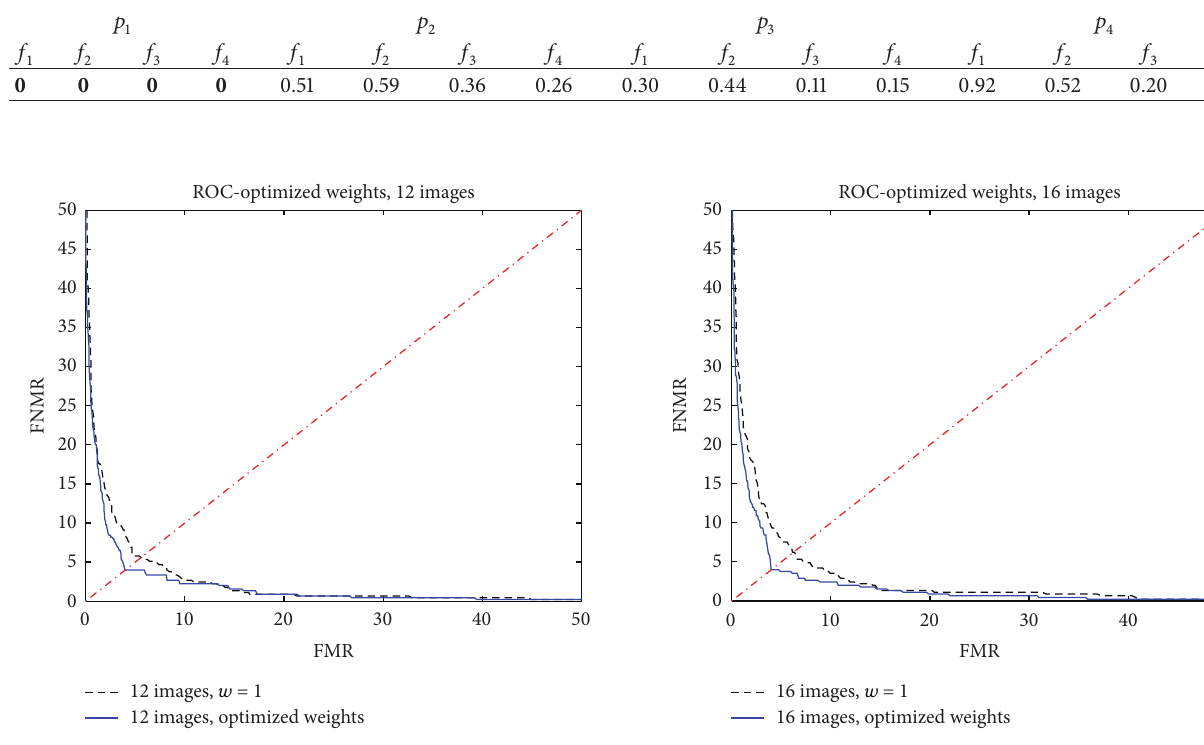
Figure 11: ROC function with 16 images: unitary weights versus optimized